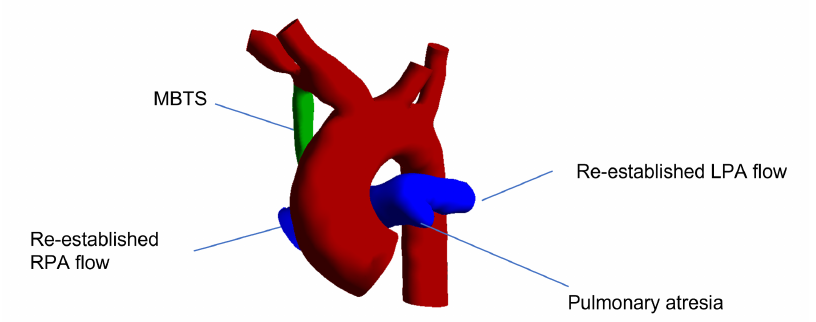
Figure 3. Results of the CAD reconstruction of the pulmonary atresia including the MBTS